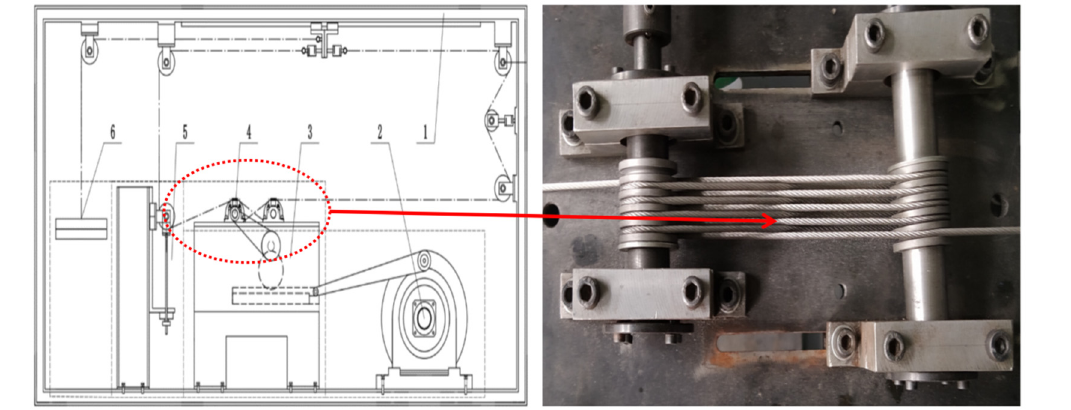
Figure 9. Self-made simulation bench.